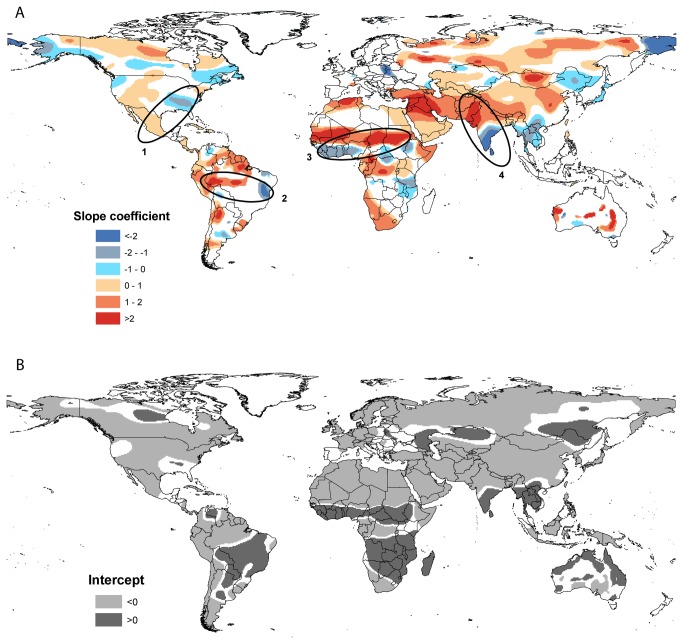
Output parameters and local R2.The upper panel (A) shows results from the GWR analysis, showing the nature of the relationship between population density and burned area for those regions where the relationship is significant at the 95% level (red shows a positive relationship, blue shows a negative relationship). The slope coefficient classes are defined separately for each continent; (B) Mapped patterns in the sign and magnitude of the statistically significant intercept values from the GWR analysis of population density and burned area. Dark grey shows positive intercept values, where the area burned is large even at negligible population density (i.e. where the landscape is naturally fire-prone), while light grey shows negative intercept values where climatic or vegetation factors do not favour fire; (C) Showing the significant patterns for both intercept and slopes according to the sign of the relationship, thus the four combinations show both out being positive (red), positive slopes and negative intercept (green), negative slopes and positive intercept (yellow) and both being negative (blue) ;(D) Mapped patterns of the local R2 for the regions where the relationship between population density and burned area is statistically significant.